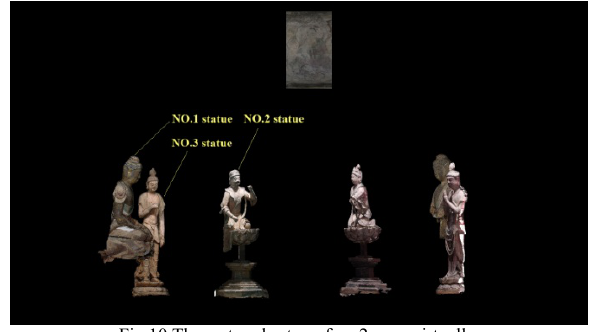
Fig.10 The restored setup of no.2 cave virtually